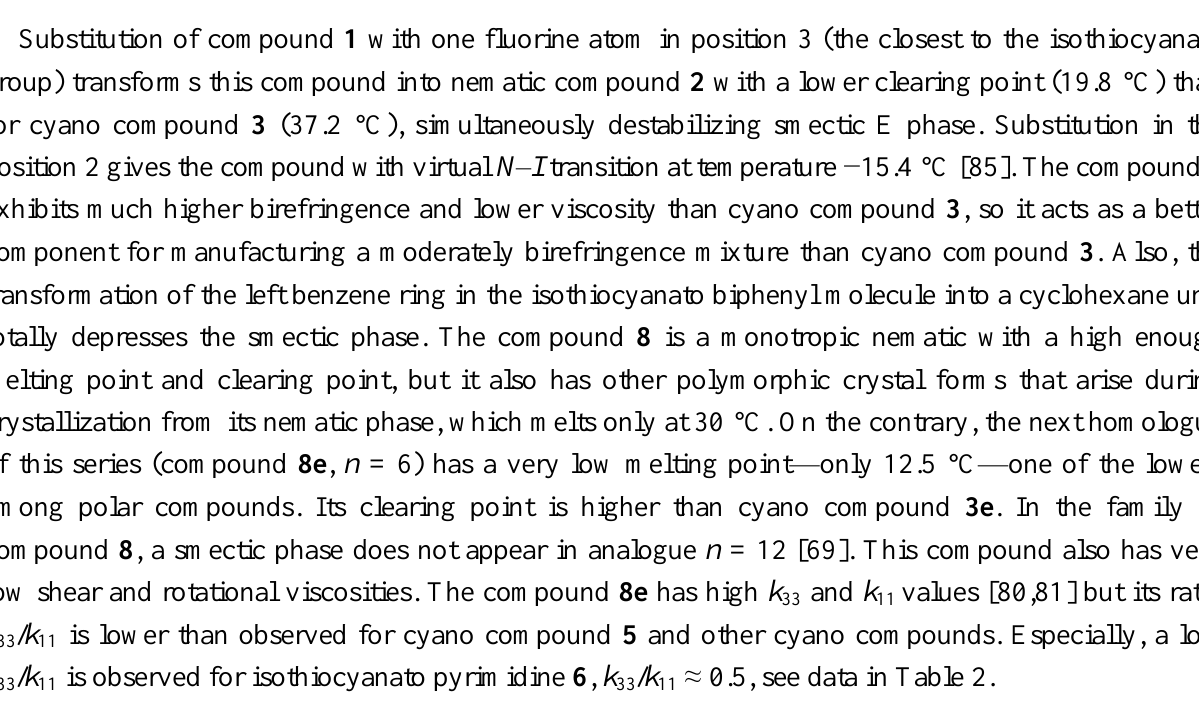
Table 2. Comparison of elastic constants [10 −12 N] for cyano- and isothiocyanato compounds at temperature T – T = 10 N–I